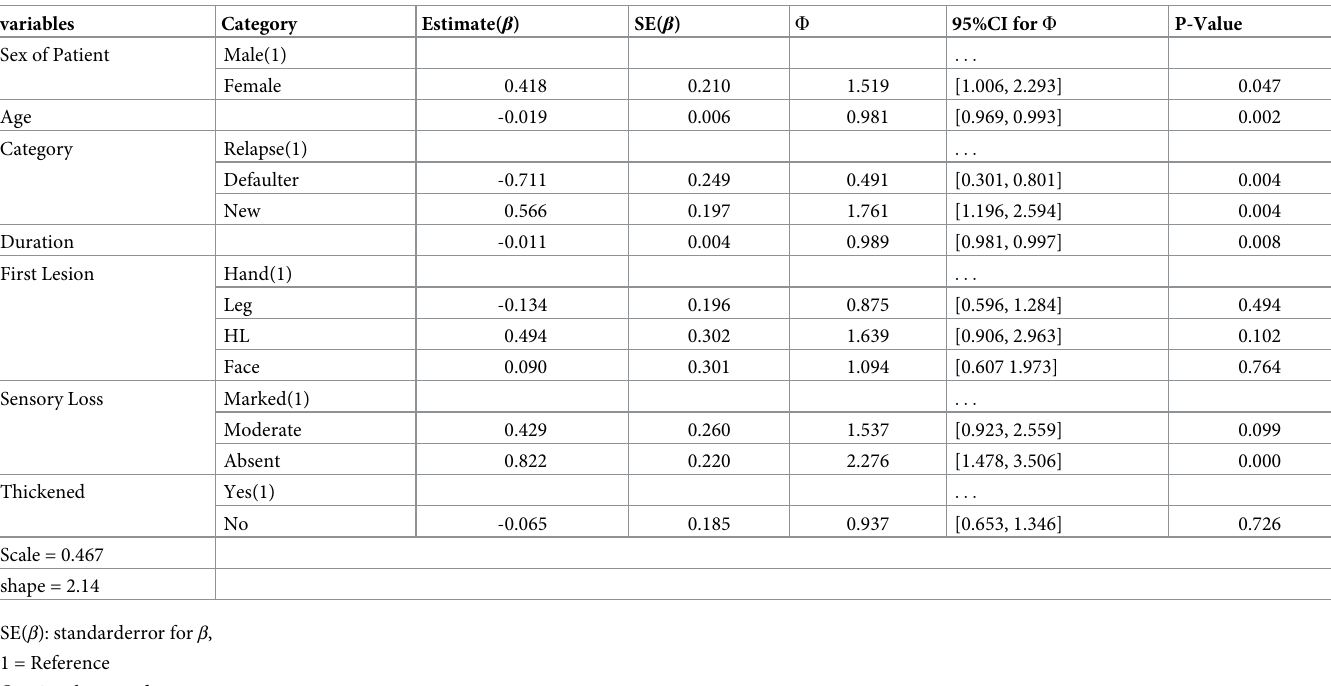
Table 6. Summary result for log-logistic acceleration failure time model for leprosy patients at ALERT center(LPAC, from